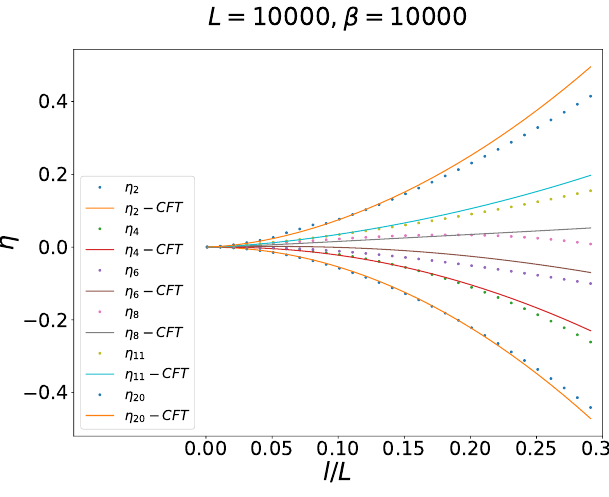
Figure 2 . Numerical calculation of the thermal correction parameter from η 2 to η 20 for the total number of grids N = 10000 . β/L is fixed at 1 . The continuous curve is the analytical result in (3.14). Before the crossover ( i ≤ 6 in this figure), all eigenvalues decrease with the increase of temperature, indicating negative η i s, while the tendency is opposite after the crossover